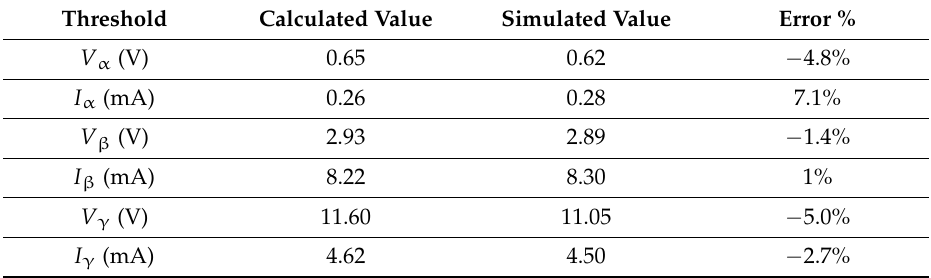
Table 1. Calculated and simulated threshold voltages and currents with junction gate field-effect transistor